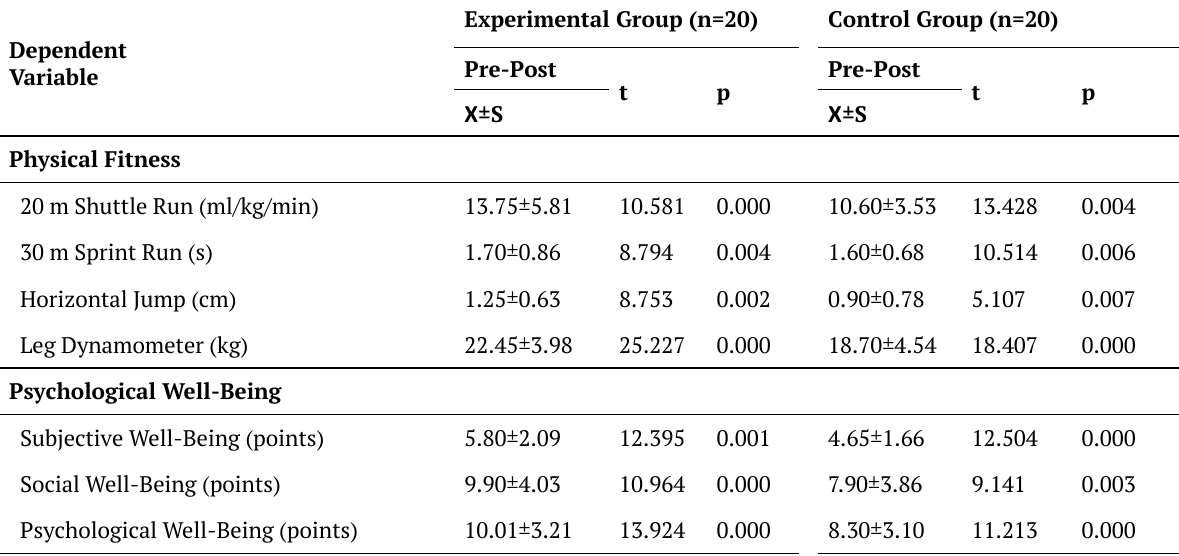
Table 6 . The results of the Paired Samples t-test